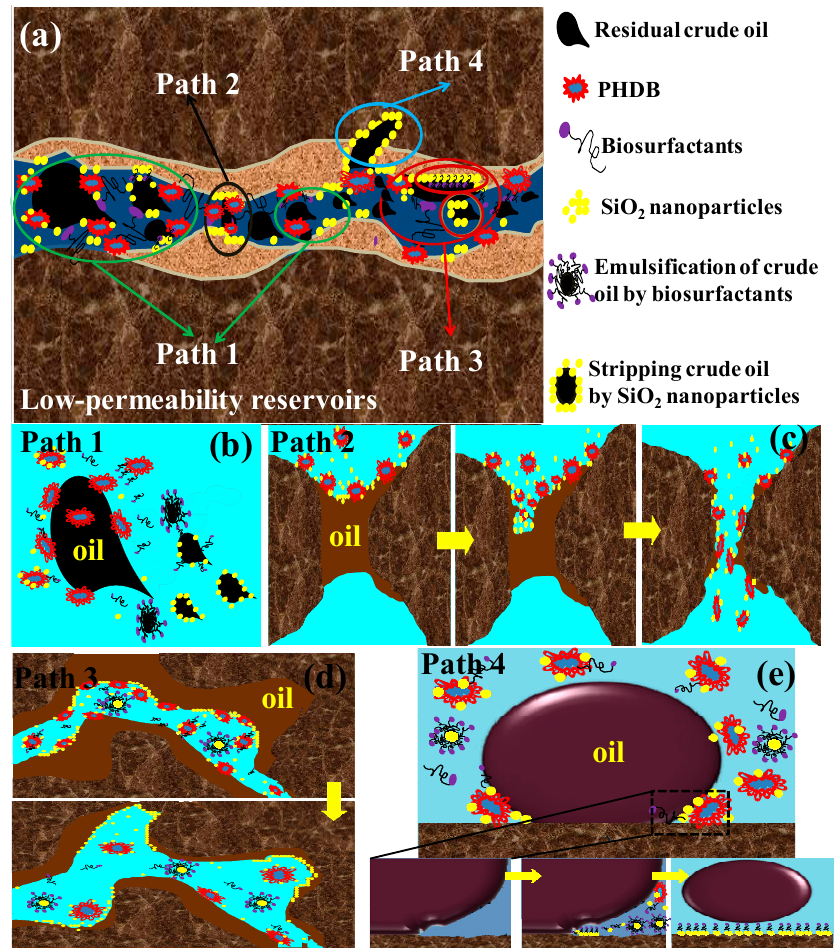
Figure 7. Schematic diagram of the mechanism of PHDB-SiO 2 nanoparticle composite flooding for enhancing oil recovery. ( a ) Collaborative pathways for EOR by PHDB-SiO 2 nanoparticle composite displacement, ( b ) Emulsification and dispersion of residual crude oil, ( c ) The clogging channels for the residual oil were dredged by PHDB-SiO 2 nanoparticle composite displacement, ( d ) The residual crude in the dead-end pores were displaced by PHDB-SiO 2 nanoparticle composite displacement, and ( e ) The residual crude oil being stripped and displaced from the rockface by PHDB-SiO 2 nanoparticle composite displacement.According to Figures 2 and S5b, a large amount of residual oil was easily trapped in the pore-throat structure and resulted in the oil layer on the pore wall after the primary water flooding. The swept volume was small because the displacing fluid could only be in contact with one side of the oil in the middle channel pores [23,32]. However, with the effect of PHDB-SiO 2 nanoparticle composite flooding, the residual oil ratio in the pore-throat decreased obviously, corresponding to an enlarged water sweep area (Figure S5e). This is because PHDB can break the oil into small droplets, resulting in accelerating emulsification and greatly promoting the dispersion of residual oil (Figure 7b), thereby increasing the contact probability between SiO 2 nanoparticles and oil droplets, and promoting the adsorption and emulsification of the residual oil by nanoparticles (Path 1). After that, the residual oil droplets encapsulated by the nanoparticles were more propitious to transport and result in EOR.